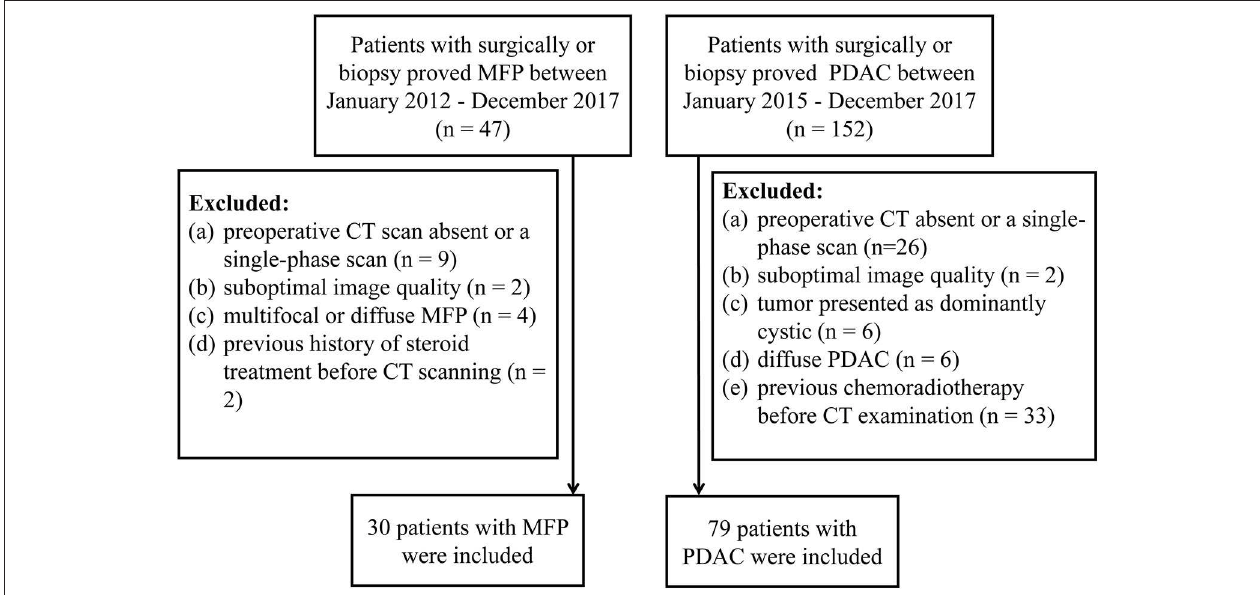
FIGURE 1 | Flow diagram of patients’